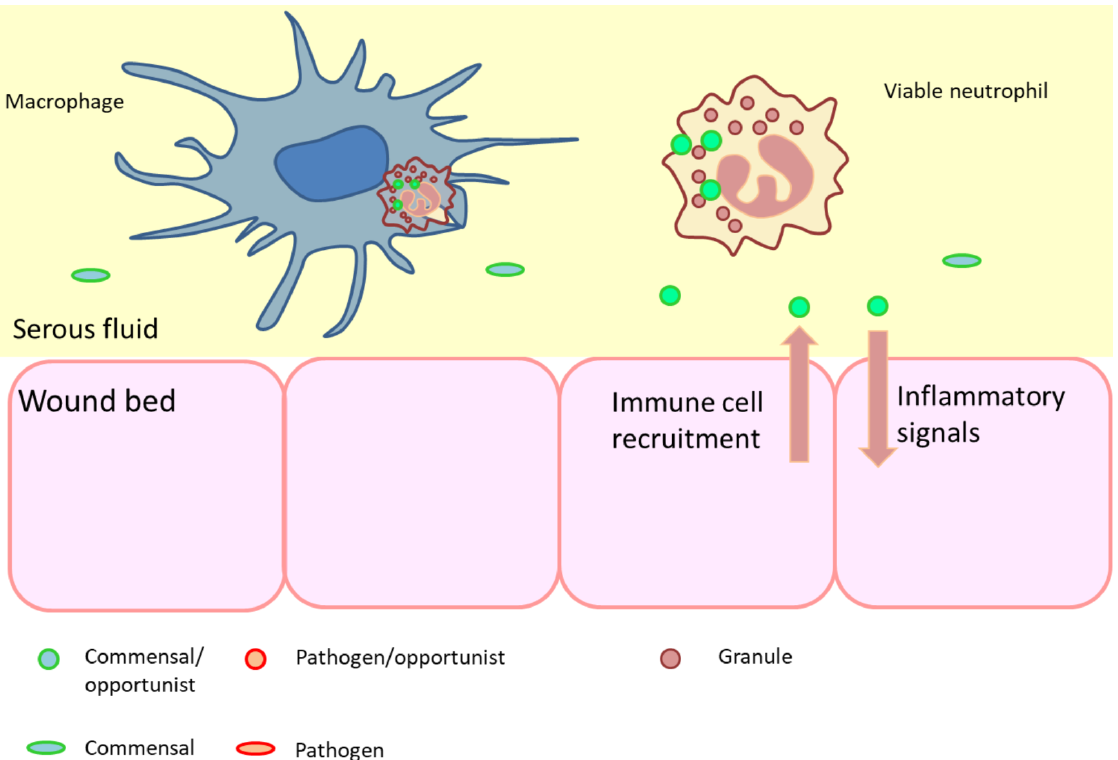
Figure 2. In a normally healing wound, microbial contamination will invariably occur, but good blood supply, immune cell function and nutrition will, in most cases, prevent progression to infec- tion. When an adequate immune function is present, organisms that stimulate immune response are cleared by viable neutrophils through phagosomal lysis, after which the neutrophil itself undergoes apoptosis and is cleared by macrophages (preventing leakage of cell materials). Signaling that at- tracts immune cells is related to tissue injury, secretion of metabolites and microbial surface pat- terns. Since commensals generally cause no harm (e.g., invade tissue), immune recruitment is lim-